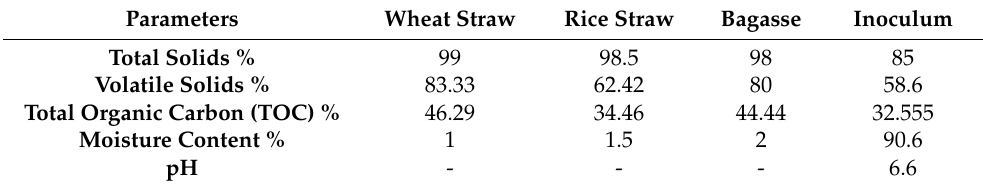
Table 1. Proximate Analysis of